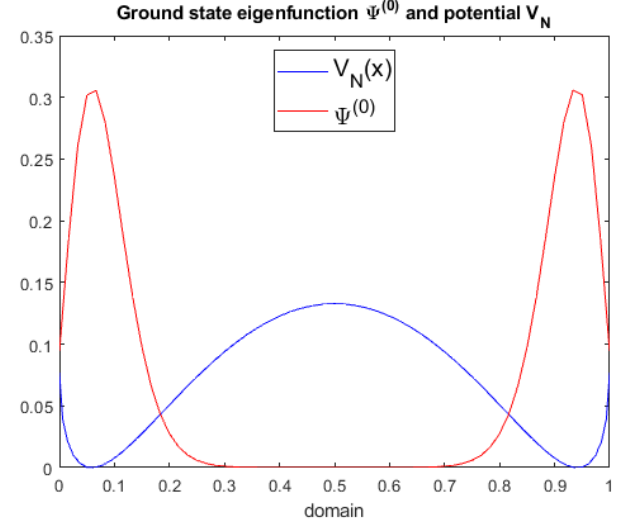
Figure 6: Scaled and shifted potential V for B = 1 / 2 and J = 1 , plotted on grid : = ˜ V N N points that are solution of the equation y = D ( x ) / L , and the ground state eigenfunction / N for N = 60 , plotted on uniform grid corresponding to J N + 1